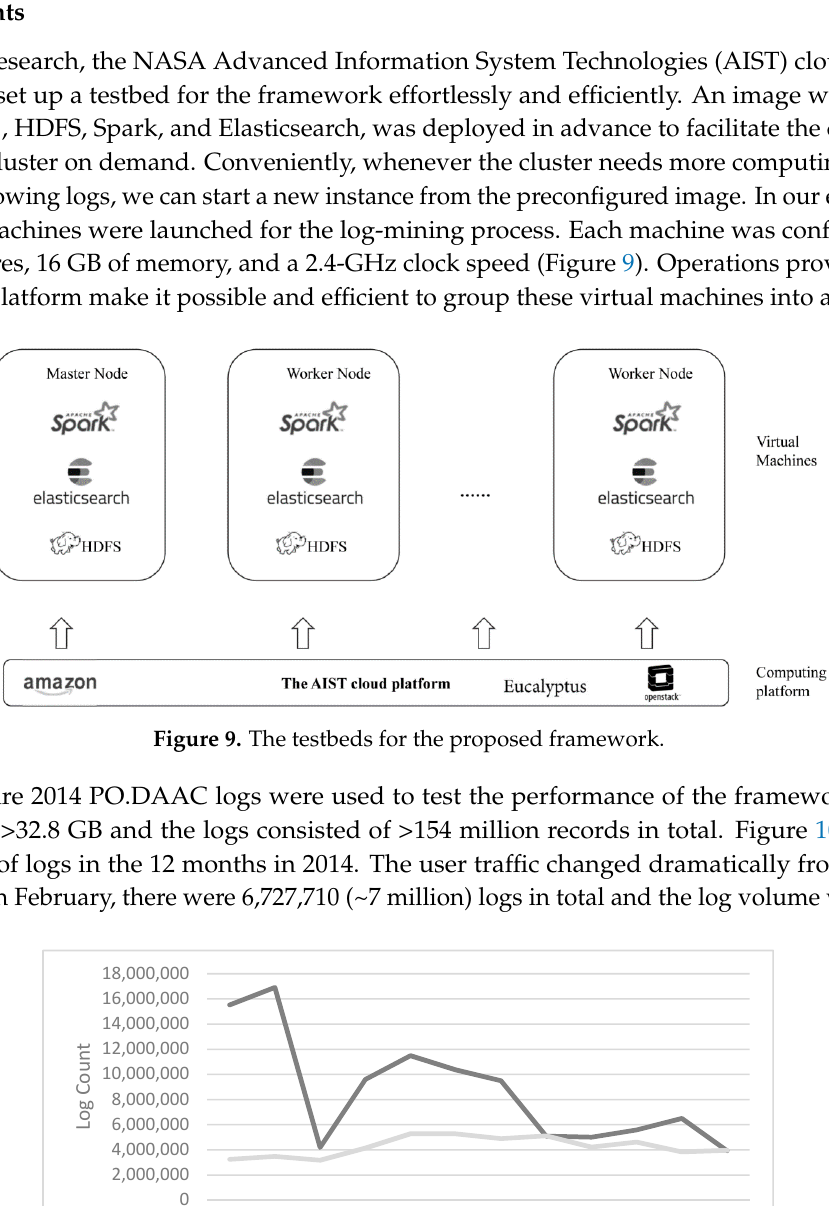
Figure 8. The pseudo code of the LogPartitioner.